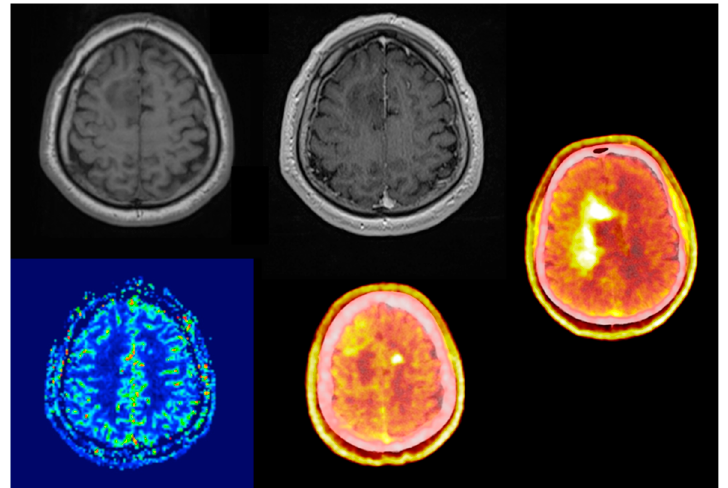
Figure 2. Sixty-three-year-old male, right frontal non-enhancing lesion known for over a year. During follow-up MRI scans no radiological progression was detectable. There were also no signs of elevated regional blood flow perfusion. No neurological deficit upon first and following presentations. PET/CT scan presented a butterfly-like very intense heterogeneous, lesion, significantly widened compared to the MRI lesion. Bilateral amino acid uptake (SUVmax: 55.81 vs. 1.58; TBRmax: 3.68) with a photopenic (SUV 1.4) area in the T1 hypointense area in the lateral part of the MRI lesion. The original T2 hyperintense lesion was photopenic (SUV: 1.4). Stereotactic biopsy revealed IDH-positive astrocytoma (grade 4), Ki-67 proliferation rate was 40%.